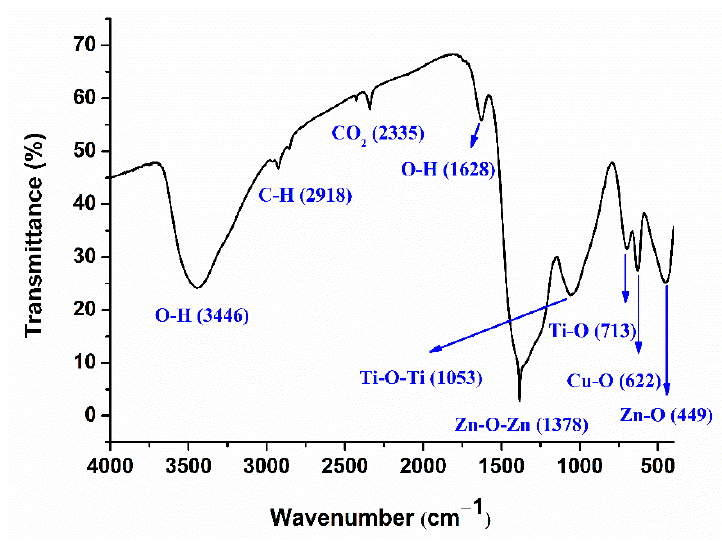
Figure 3. FTIR of the Cu-ZnO/TiO 2 (CZT-2) nanocomposite photocatalyst. The BET surface area of CZT-2 evaluated from the BET surface area plot, as shown in Figure 4a,b, was estimated to be 60.52 m 2 /g. The external surface area and micropore volume were determined using the t-plot method and were 31.25 m 2 /g and 13.98 m 2 /g, respectively.